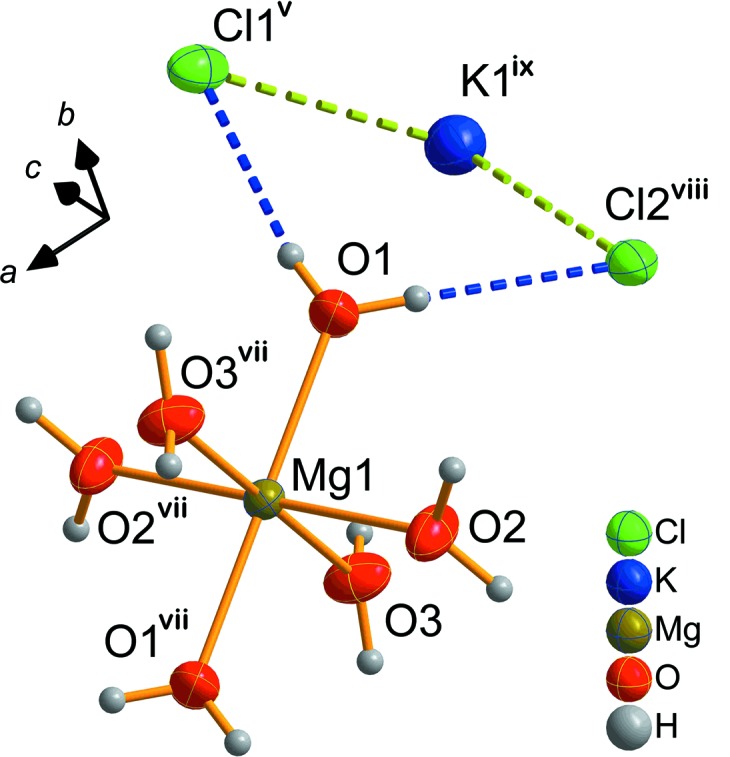
The asymmetric unit and symmetry-related atoms of KCl·MgCl2·6H2O. Displacement ellipsoids are drawn at the 50% probability level and H atoms are not labelled. [Symmetry codes: (v) x + , −y + , z + ; (vii) −x + 2, −y + 1, −z + 1; (viii) −x + , y − , −z + ; (ix) −x + , −y + , −z + 1.]